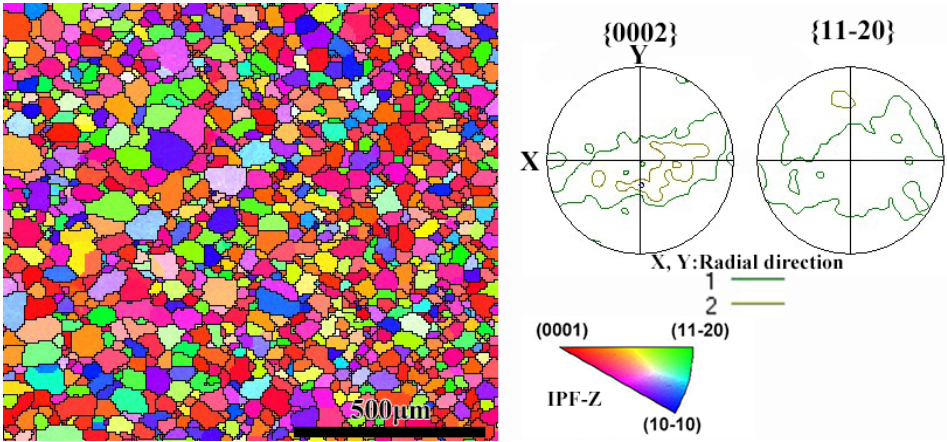
Figure 1. Orientation map with IPF (inverse pole figure) colors and pole figures of forged commercial titanium bar.